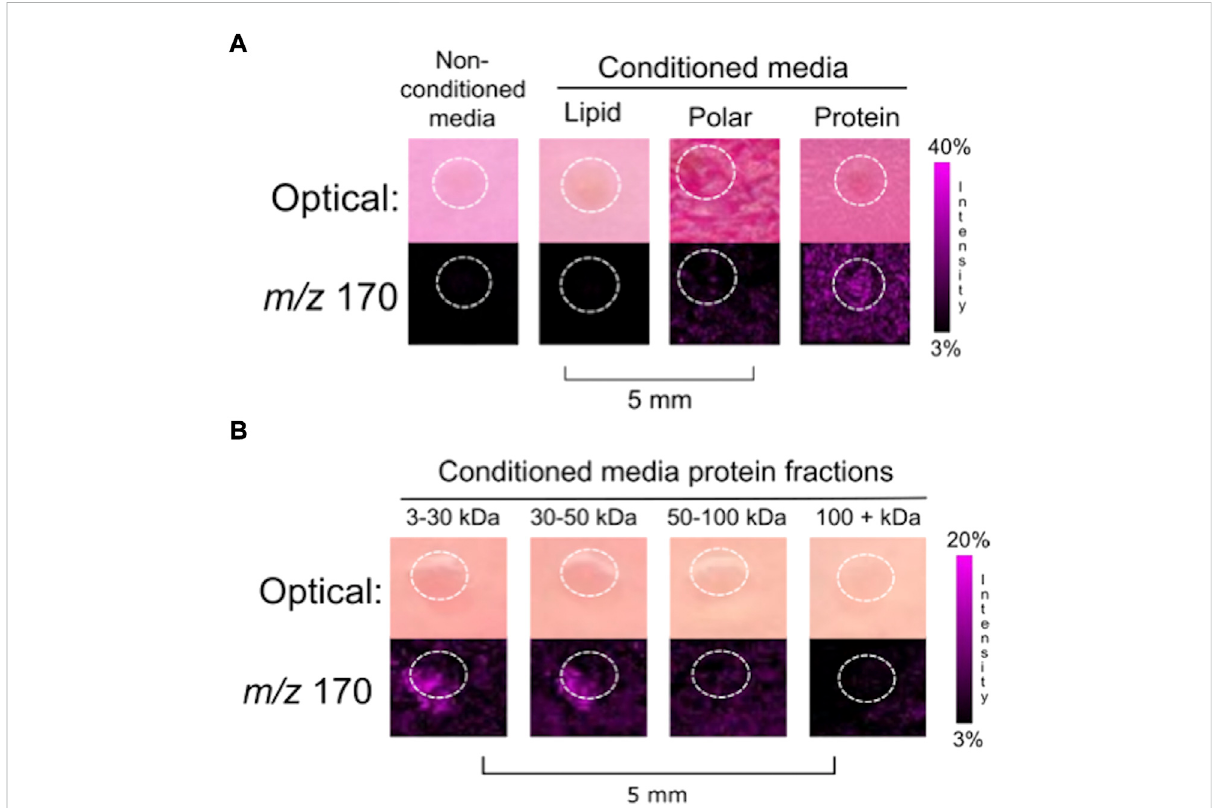
FIGURE 1 Fractionation of (A) MOE PTEN shRNA conditioned media into biomolecular classes generated three generalized fractions: lipids, polar compounds,andproteins.Emptymediawasincludedasanegativecontrol.Theco-cultureofamurineovarywiththeproteinfractionresultedinthe release of ovarian NE. (B) Finer fractionation of the protein collection was done to generate four collections of limited mass ranges. Ovarian NE was releasedinco-culturewithboththe3 – 30kDaand30 – 50kDaproteinfractionsofMOEPTEN shRNA conditionedmedia.Ovariesarecircledwitha white dotted line. IMS Method A was used for this fi